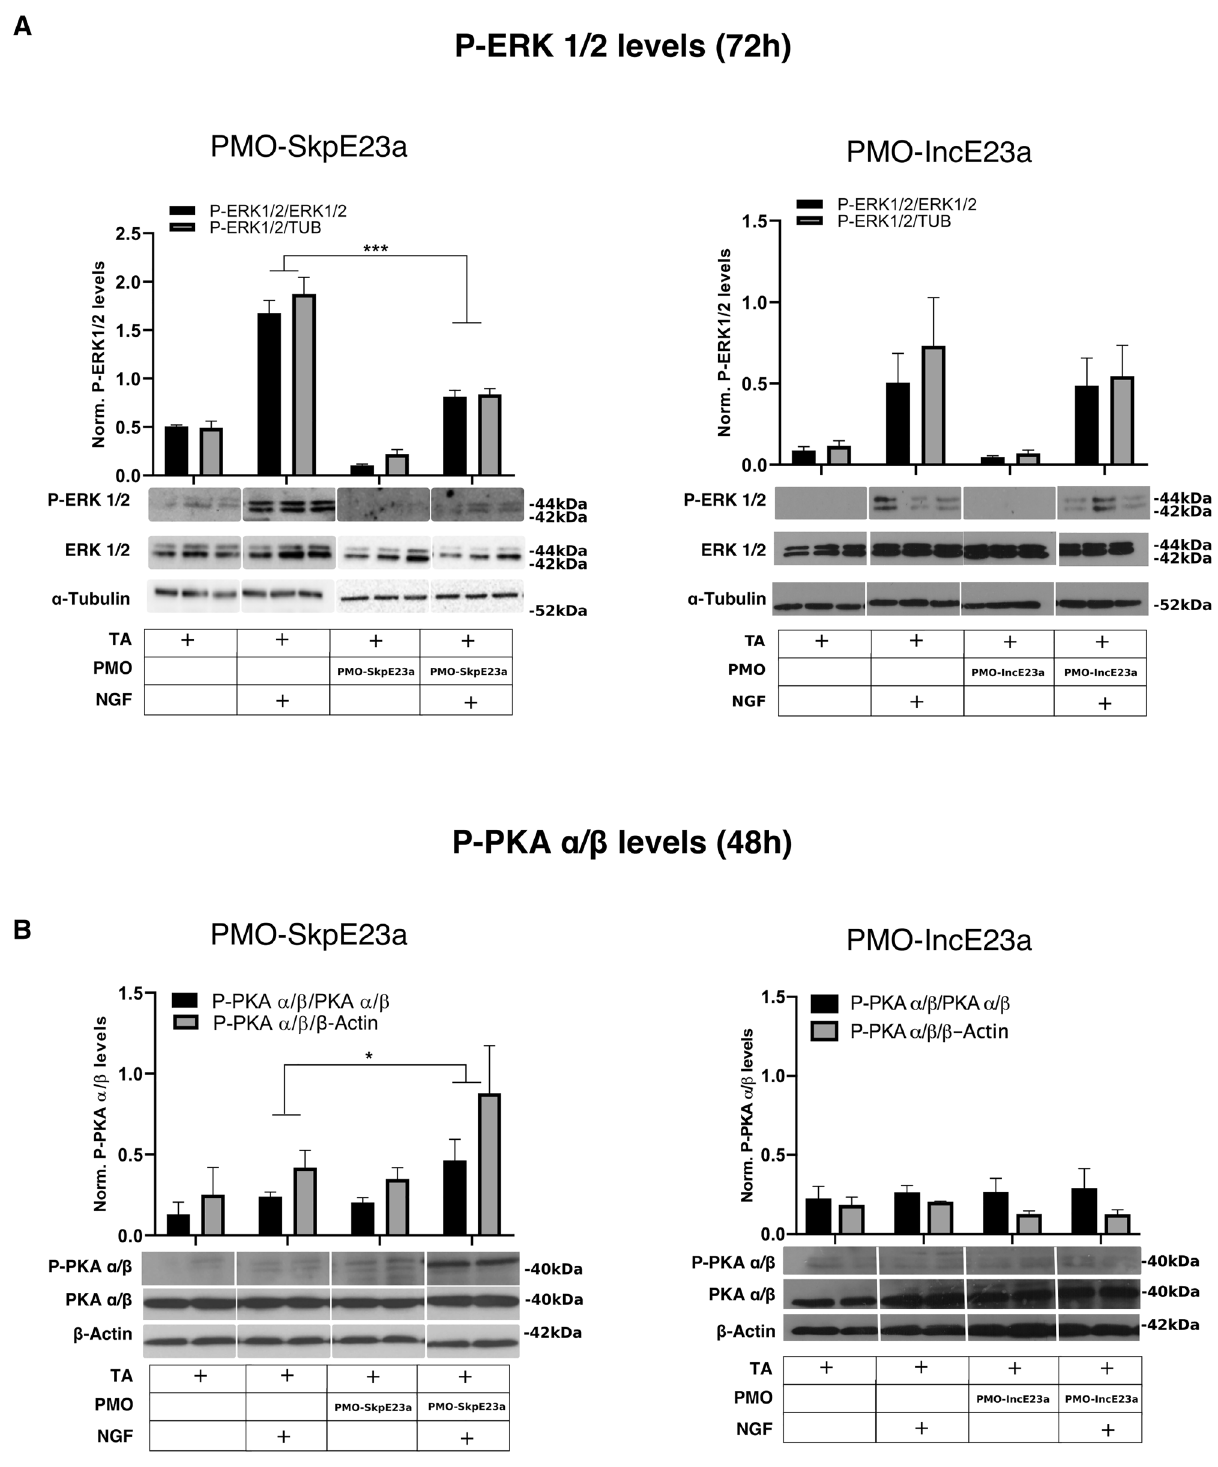
Figure 6. Effect of E23a skipping or inclusion by PMO treatment on the activation of ERK and PKA during NGF-induced PC12 neuronal differentiation. ( A ) Western blot analysis and quantification of P-ERK1/2, total ERK1/2 and alpha-tubulin levels after forcing E23a skipping (PMO-SkpE23a) or inclusion (PMO-IncE23a) at 72 h after NGF treatment at different experimental conditions summarized in a box below each graph/western. *** P < 0.001, paired t -test versus cells treated only with NGF. Bars indicate Mean ± SEM. ( B ) Western blot analysis and quantification of P-PKAαβ, total PKAαβ and β-actin, at the same conditions as in ( A ), but 48 h after NGF treatment. * P < 0.05, paired t -test versus cells treated only with NGF. Bars indicate Mean ± SEM. TA: transfection agent. Supporting whole gel images can be found in Supplementary Fig.